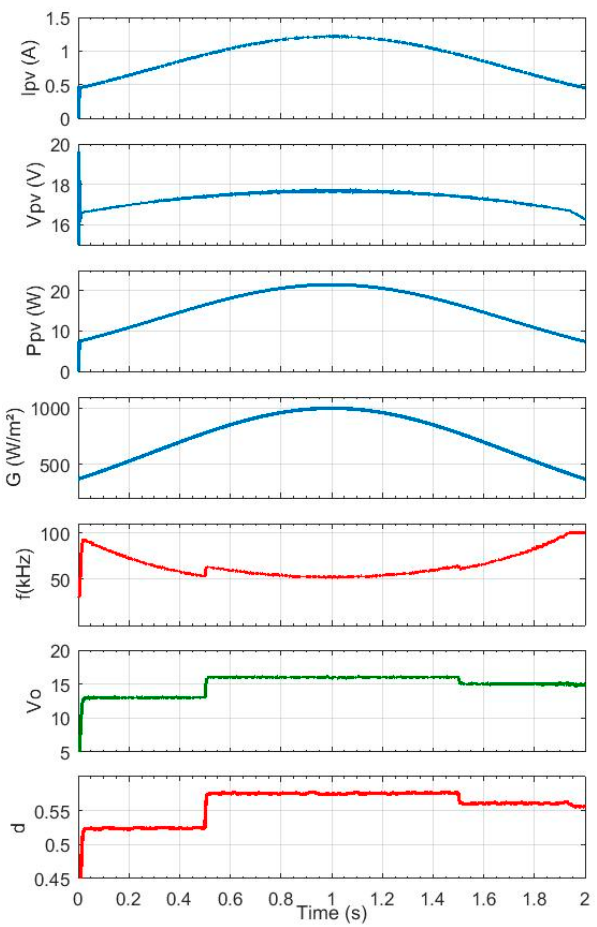
Figure 8. Simulation results for the conversion circuit based on two switches S 1 and S 2 (Figure 5, top). From top to bottom: I pv , V pv , P pv , G , f , V O and D .